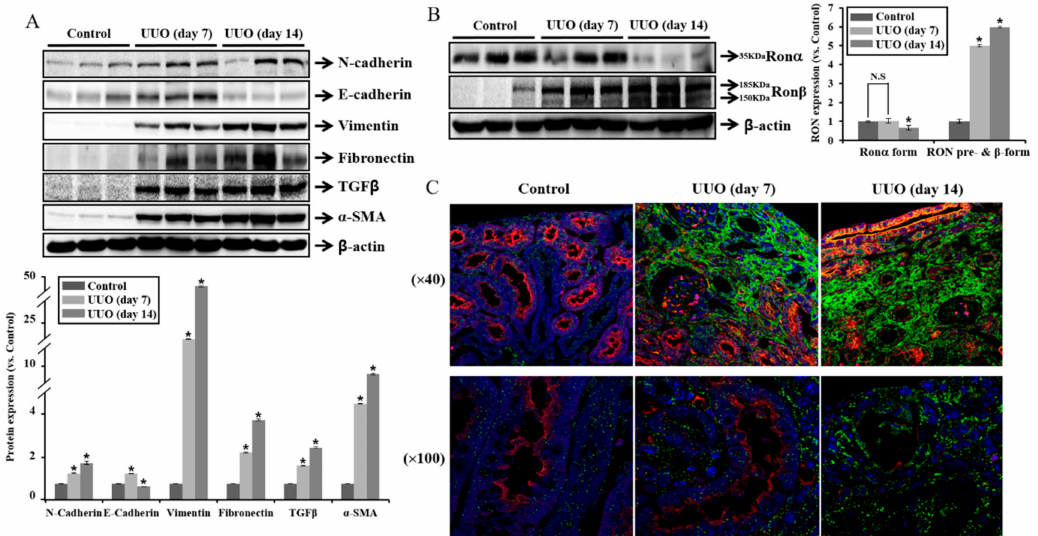
Figure 1. Expression of RON, epithelial mesenchymal transition (EMT), and pro-fibrotic markers in obstructed mouse kidneys. The unilateral ureteral obstruction (UUO) lasted for 7 day and 14 days. ( A ) Protein expression of N-cadherin, E-cadherin, vimentin, fibronectin, TGF β , and α -SMA were analyzed. ( B ) Protein expression of RON α and RON β were analyzed. ( C ) RON-receptor tyrosine kinase expression was evaluated by confocal microscopy. The RON expression was observed as a green label. The expression of AQP-1 (red label) was used as a marker of the proximal tubule, and 4 (cid:48) , 6-diamidino-2-phenylindole (DAPI: blue label) was used as a maker of the nuclei. Each column represents the mean ± SEM. * p < 0.05, compared with the UUO control group. N.S, statistically not